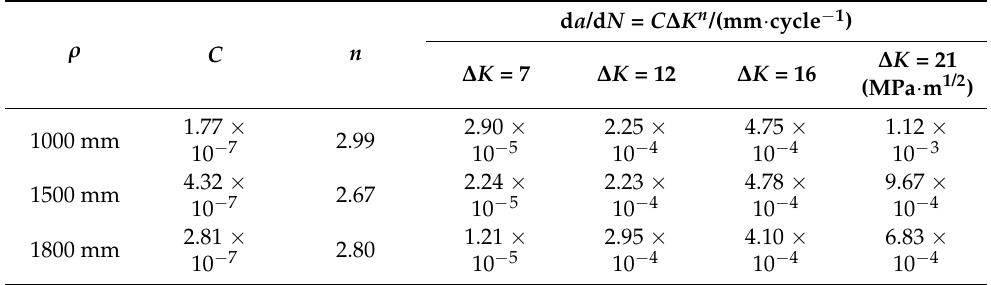
Table 3. Paris fitting parameters C and n of 2524 aluminum alloy under different creep stresses.